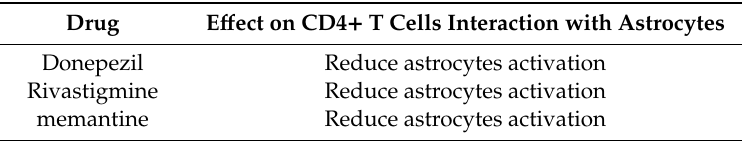
Table 9. E ff ect of drugs on astrocytes interaction with CD4 + T